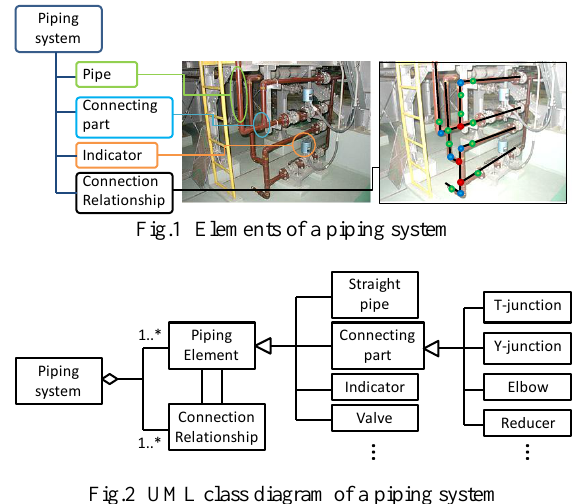
Fig.2 UML class diagram of a piping